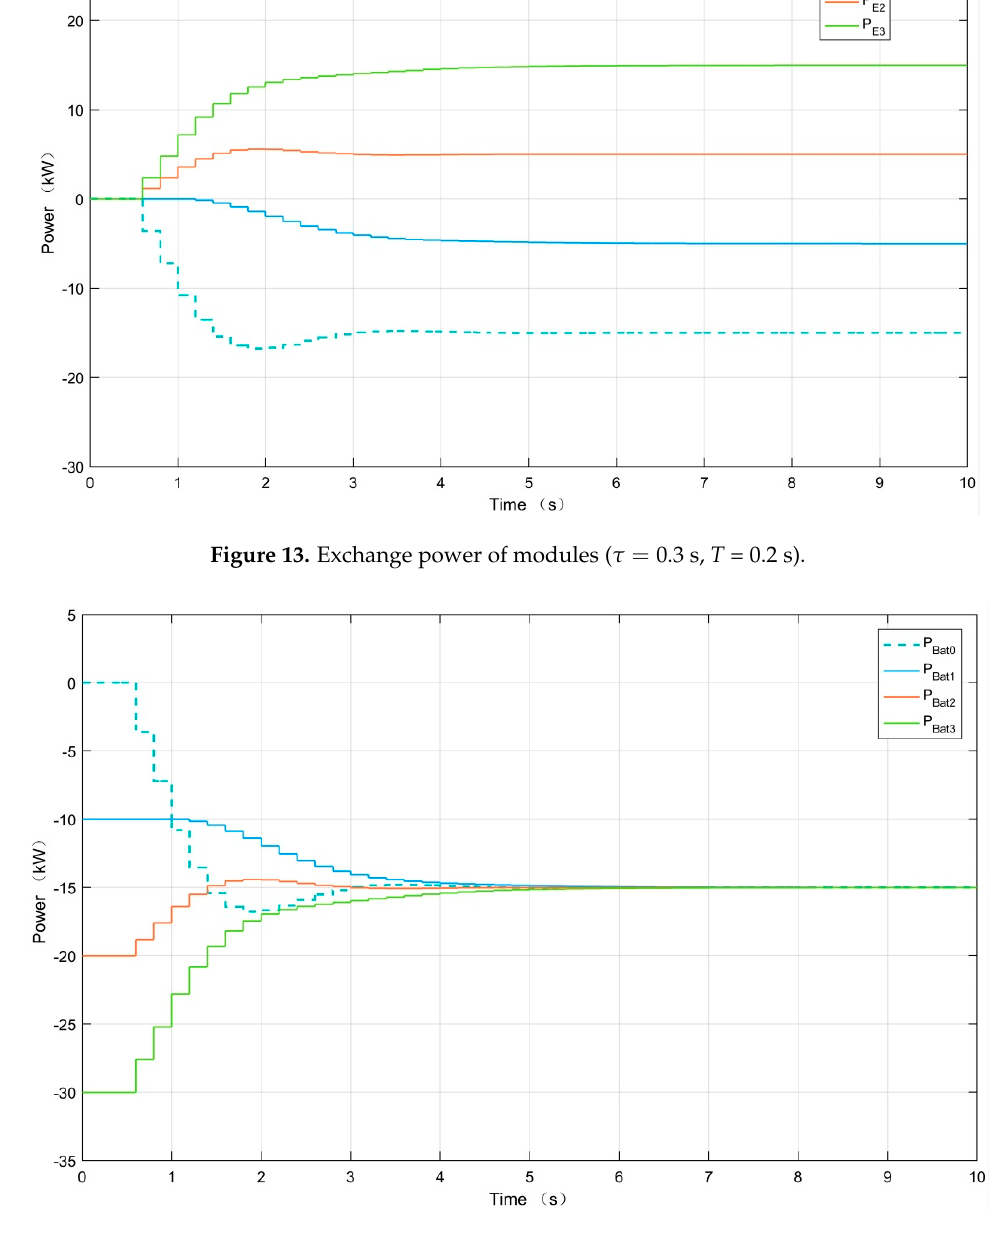
Figure 14. Battery power in modules ( τ = 0.3 s, T = 0.2 s).